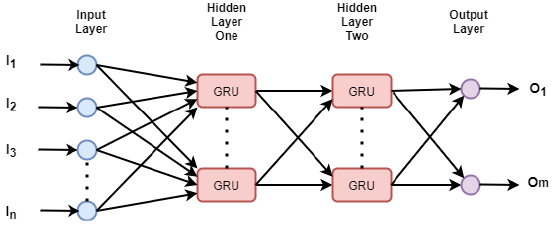
Figure 1. A neural network based on GRU